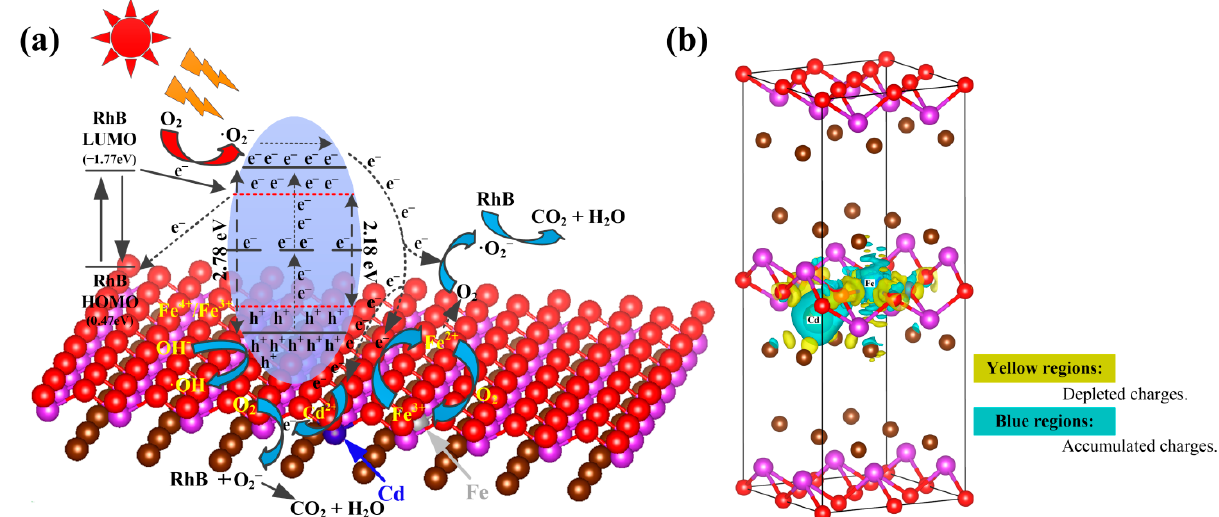
Figure 8. Proposed mechanism of photocatalytic activity by Bi 1 − x − y Cd x Fe y OBr photocatalyst ( a ); calculated charge density difference of Bi 1 − x − y Cd x Fe y OBr ( b ).